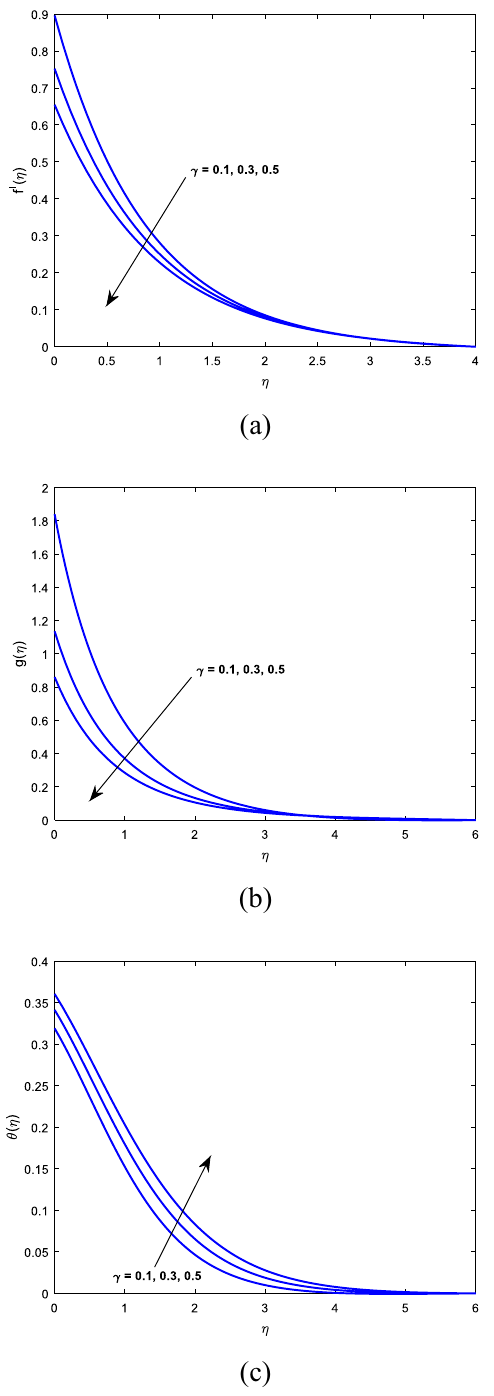
Figure 7. Impact of γ on ( a ) velocity ( b ) microrotation ( c )